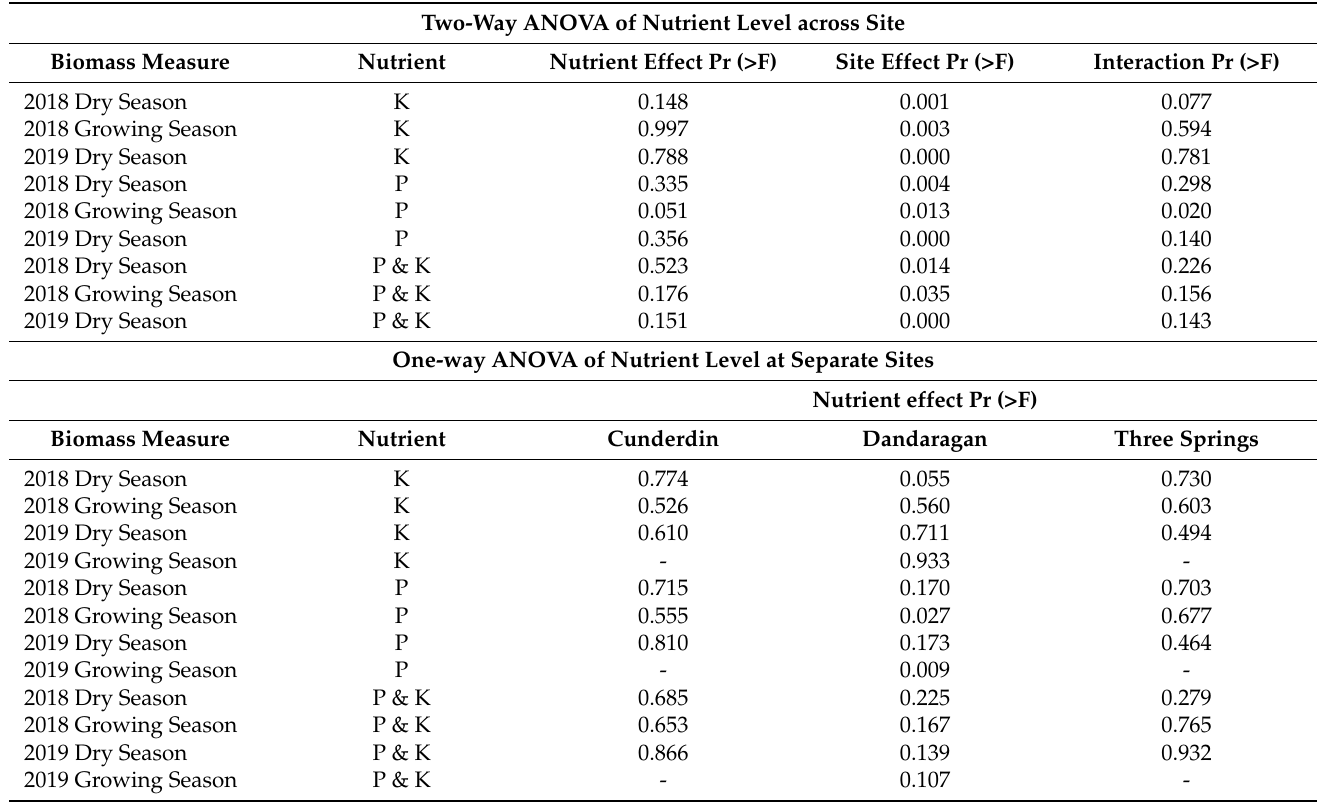
Table 5. ANOVA of added P and K effects on harvested biomass in dry seasons of 2018 and 2019 and growing seasons in 2018 and 2019 at three field sites. Analyses were two-way ANOVAs of both nutrient level and site effects and one-way ANOVAs of the nutrient level effect at separate sites. Measures were not available in the 2019 growing season at Cunderdin or Three